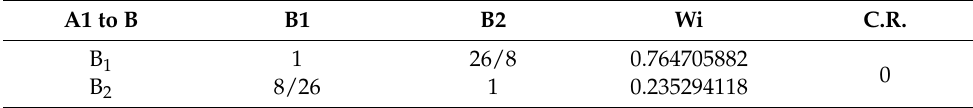
Table 7. Judgment Matrix of Z to A.